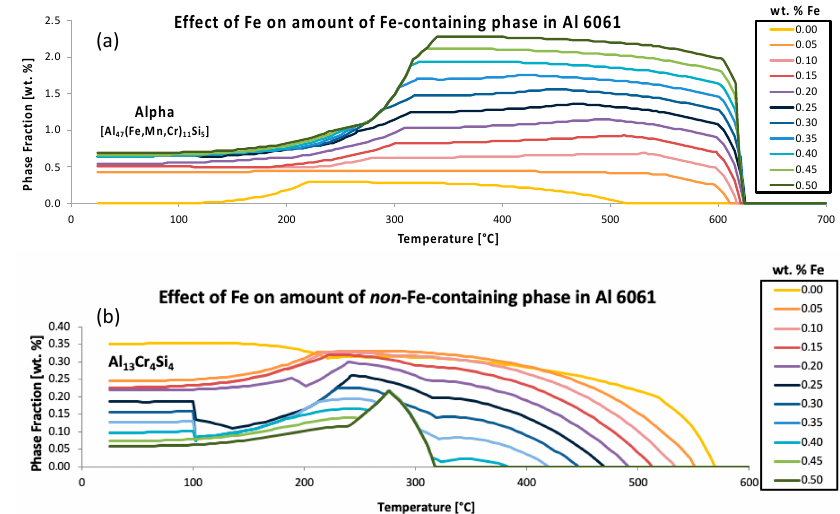
Figure 6. ( a ) The variation of the predicted equilibrium alpha phase in Al 6061 with a compositional variation of iron as a function of temperature. The graphical rendering, shown in ( a ), of alpha phase fractions as a function of temperature, for a range of iron contents, enabled the exploration of the effect of iron on the amount of an iron-containing phase in Al 6061. Alternatively, ( b ) is similar to ( a ); however, ( b ) concerns the predicted equilibrium Al 13 Cr 4 Si 4 phase in Al 6061 with a content variation of iron as a function of temperature. Consequently, the graphical rendering presented in ( b ) of the Al 13 Cr 4 Si 4 phase fractions as a function of temperature for a range of iron contents also enabled the exploration of the effect of iron on the amount of a non-iron-containing phase in an Al 6061 system.